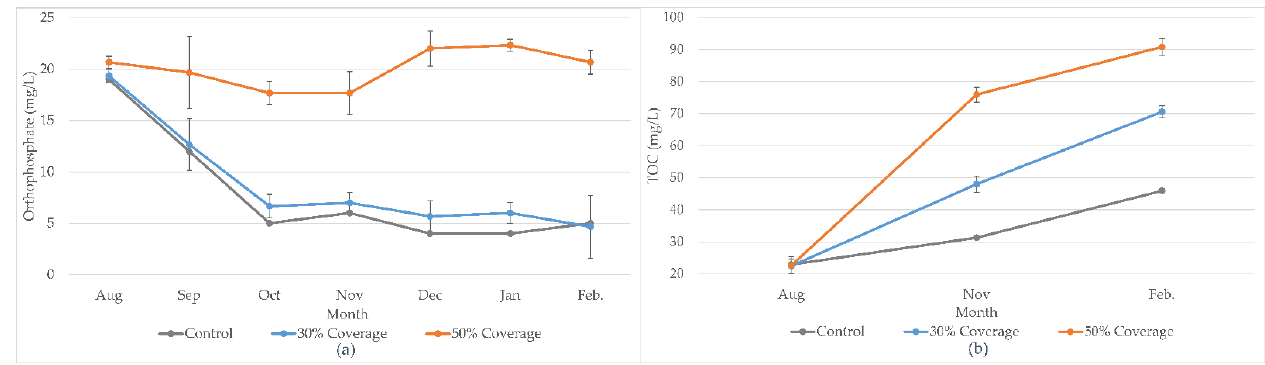
Figure 8. ( a ) Variation of orthophosphate during the experimental period. ( b ) Levels of TOC during the experimental period.